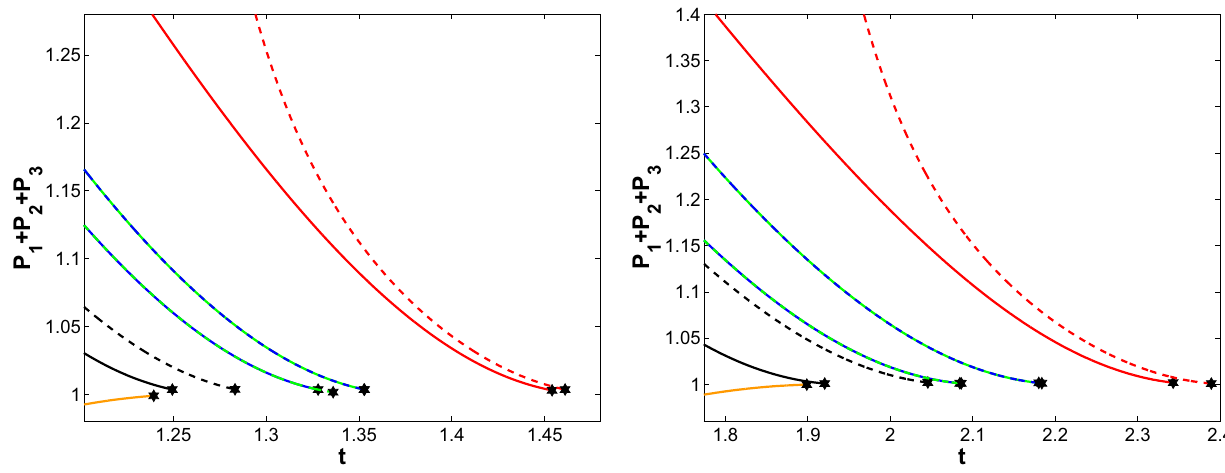
Fig. 3 The final stage of the evolution of the sum P 1 + P 2 + P 3 for N = 2, f 0 = 1 H b ( 0 ) are chosen as in Fig. 1 (see the corresponding colors and types of line). The black star denotes the moment of a cosmological singularity